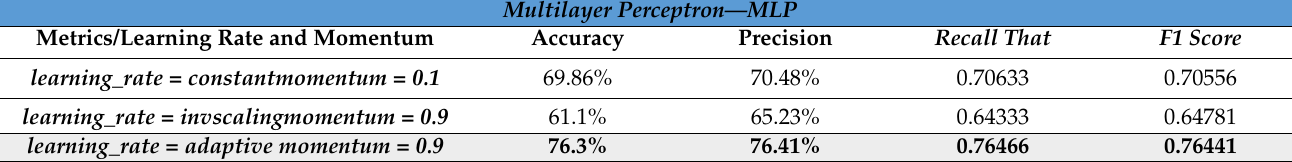
Table 8. Benchmark for Multilayer Perceptron (MLP).